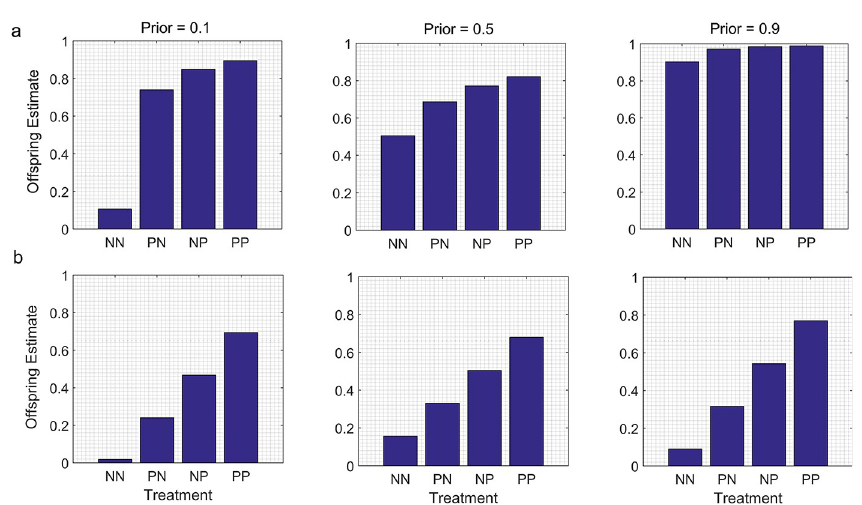
Fig 2. Duration of exposure to the same cues is longer for offspring than for parents. In the P treatment groups, parents are exposed to the presence of cues from predators for two of four time intervals, but offspring are exposed to cues from predators for all four time intervals (see text). a. N- models. In this example, the likelihood function for exposure to cues from a predator for one time interval has a shape indicated by α = 2.5, β = 1; the likelihood function for the absence of cues for one interval has a shape indicated by a uniform distribution ( α = 1, β = 1). b. N � models. In this example, the likelihood function for exposure to cues from a predator for one interval has a shape indicated by α = 2.5, β = 1; the likelihood function for the absence of cues for one interval has a shape indicated by α = 1, β = 2.5.